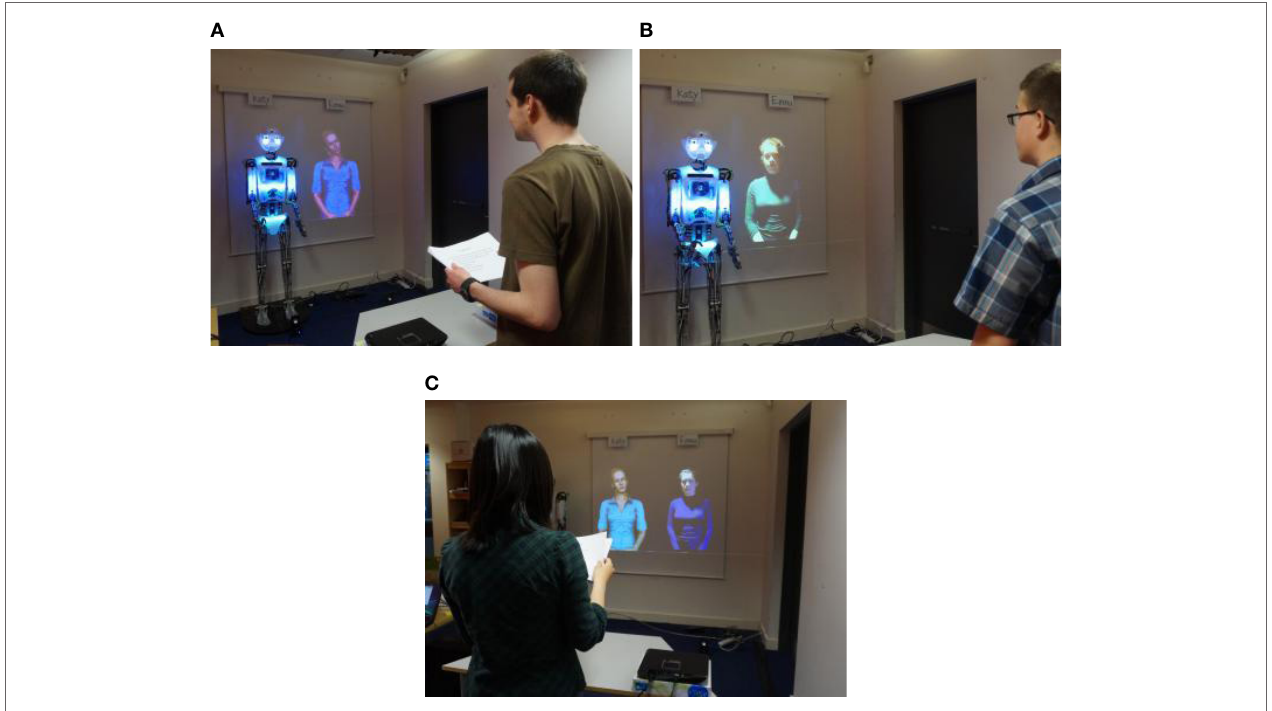
FigUre 3 | Pictures of experiment setup for different experimental conditions . (a) Robot vs. avatar, (B) robot vs. video, and (c) avatar vs.